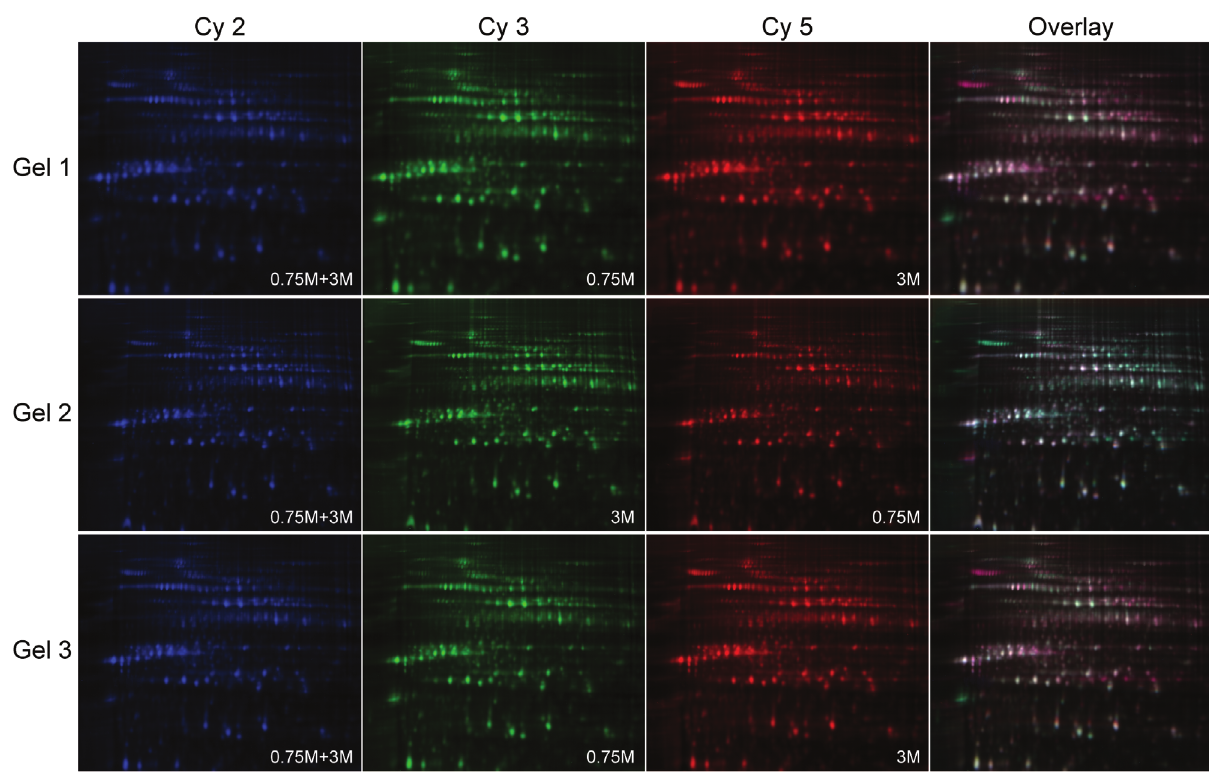
Figure 2 - 2-D DIGE gel images of proteins after exposure to salt stress in high (3 M) and low (0.75 M) salinity. The proteins were labeled with Cy2 [col- umn 1, a pool (0.75M + 3M) consisting of the same amount of each sample as an internal standard to control for quantitative comparisons, scanning at wavelength of 488/520 nm], Cy3 (column 2, scanning at wavelength of 532/580 nm) or Cy5 (column 3, scanning at wavelength of 633/670 nm) fluores- cent dyes; column 4 is an overlay of the first three columns. Gel1, 2, 3: triplicate gels for protein samples to reduce the gel-to-gel variations. Gel1: